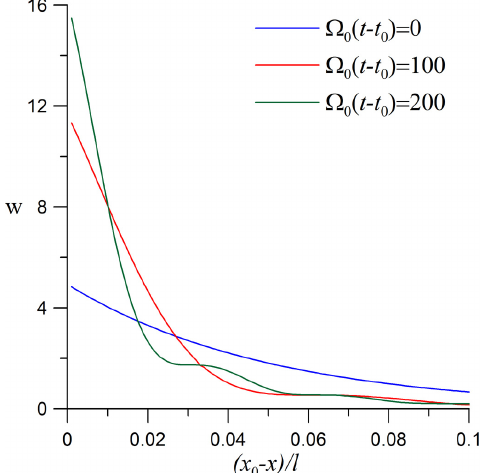
Fig. 7. Wave energy density, w , at different distances from the sur- face of the impulse x 0 for different